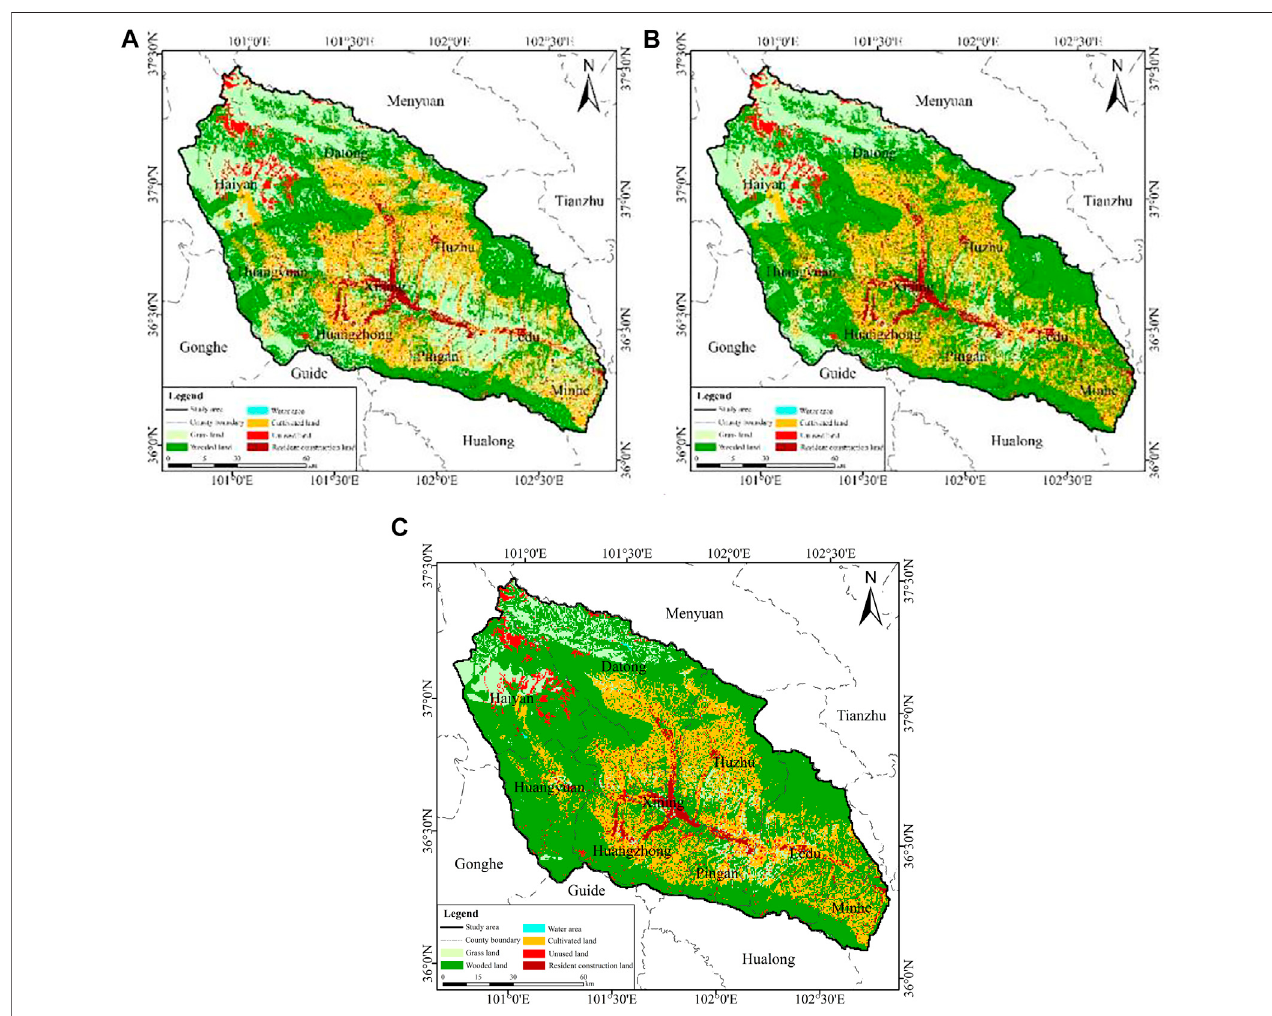
FIGURE 4 | Different levels of layout schemes of slope ecological restoration: (A) generally suitable, (B) moderately suitable and (C) highly suitable.